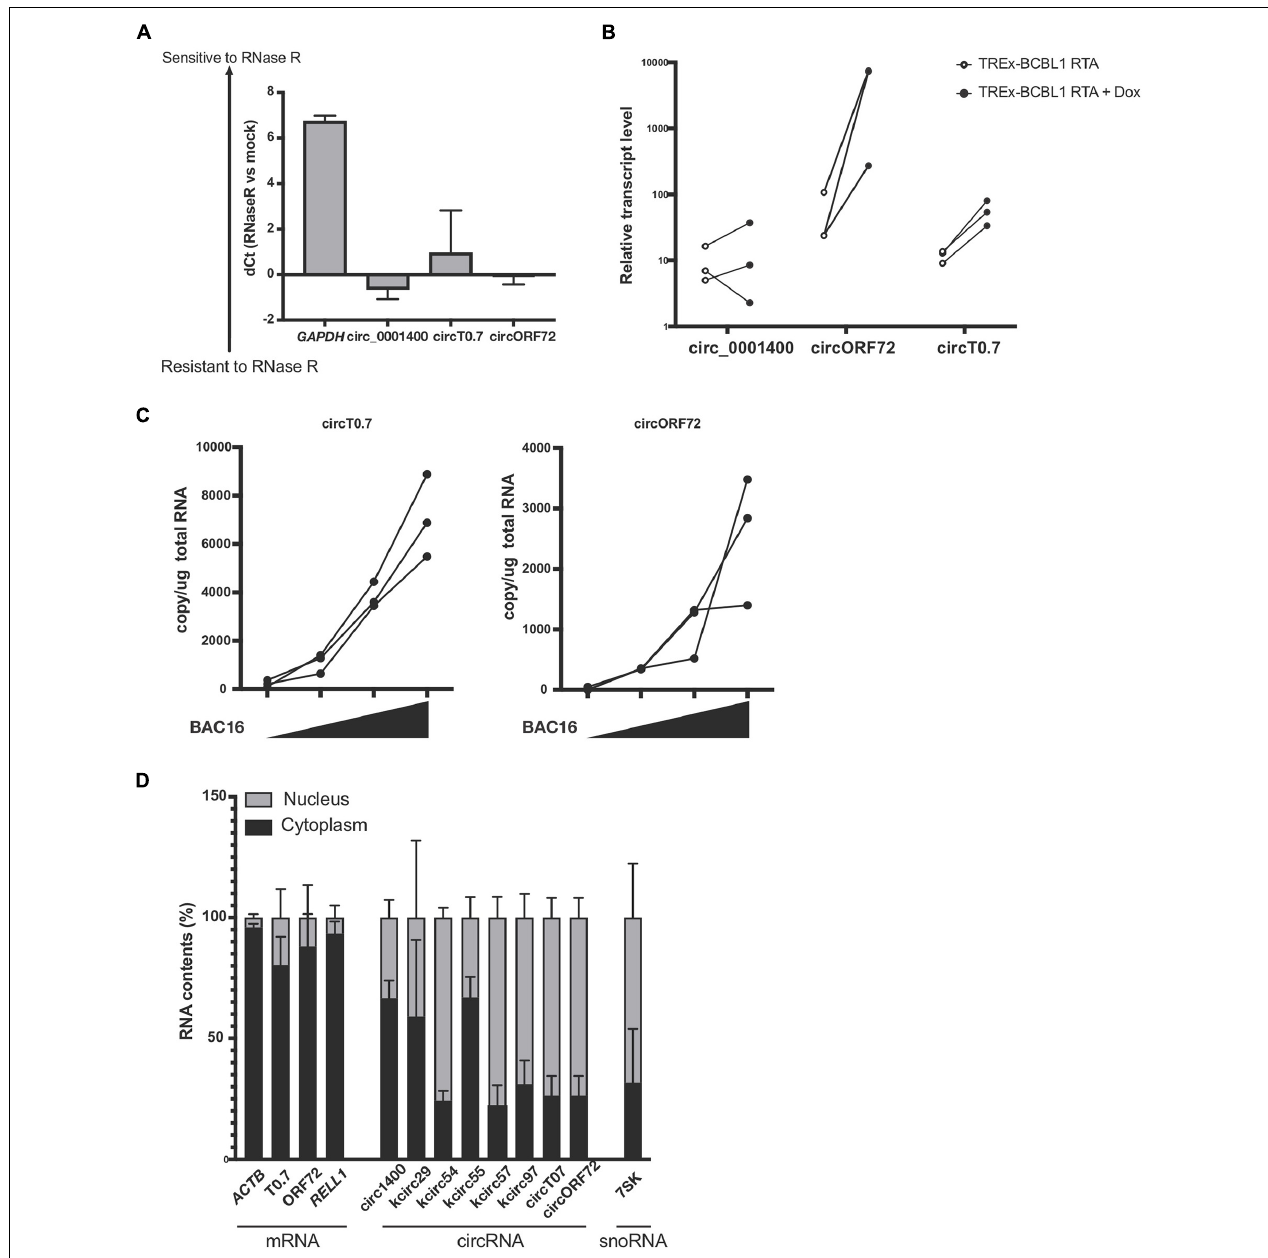
FIGURE 3 | Expression of circRNAs in KSHV T0.7 and ORF72 ORFs. (A) circRNA resistance to RNase R-mediated degradation. Total RNA from reactivated TREx-BCBL1 RTA cells was treated with RNase R and subjected to RT-qPCR. Delta of Ct values between mock and RNase R-treated samples are shown (RNase R degradation is denoted by higher dCt values). GAPDH and hsa_circ_0001400 are controls of linear and circular RNA, respectively. n = 3. (B) Expression of kshv circT0.7 and circORF72 in reactivated TREx-BCBL1 RTA cells for 2 days. Extracted total RNAs were subjected to RT-qPCR with divergent primers. GAPDH was used as internal control ( n = 3). (C) Expression of circT0.7 and circORF72 in de novo infected LECs with increasing amounts of KSHV BAC16 at MOI of 0, 15, 30, or 45, as determined by LANA copy number. Total RNAs were extracted at 3 days post infection and subjected to RT-ddPCR with divergent primers. Absolute copy numbers were quantitated and normalized to 1 µ g total RNA for each condition ( n = 3). (D) Localization of viral circRNA in reactivated TREx-BCBL1 RTA cells. Nuclear and cytoplasmic RNA contents were purified after reactivation and subject to RT-qPCR. Delta Ct values between nuclear and cytoplasmic amounts of each RNA species were calculated and are shown as percentages ( n = 3). Error bars indicate standard